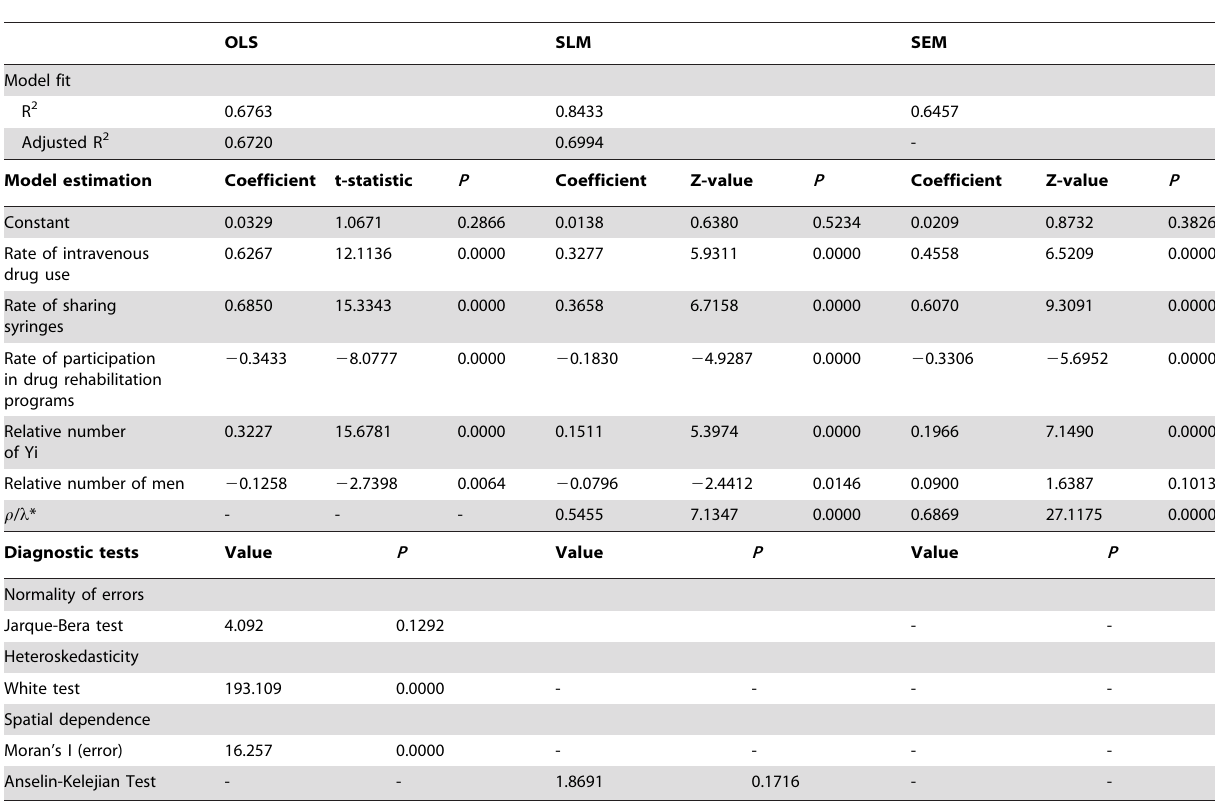
Table 1. Association of the prevalence of HIV infection and risk